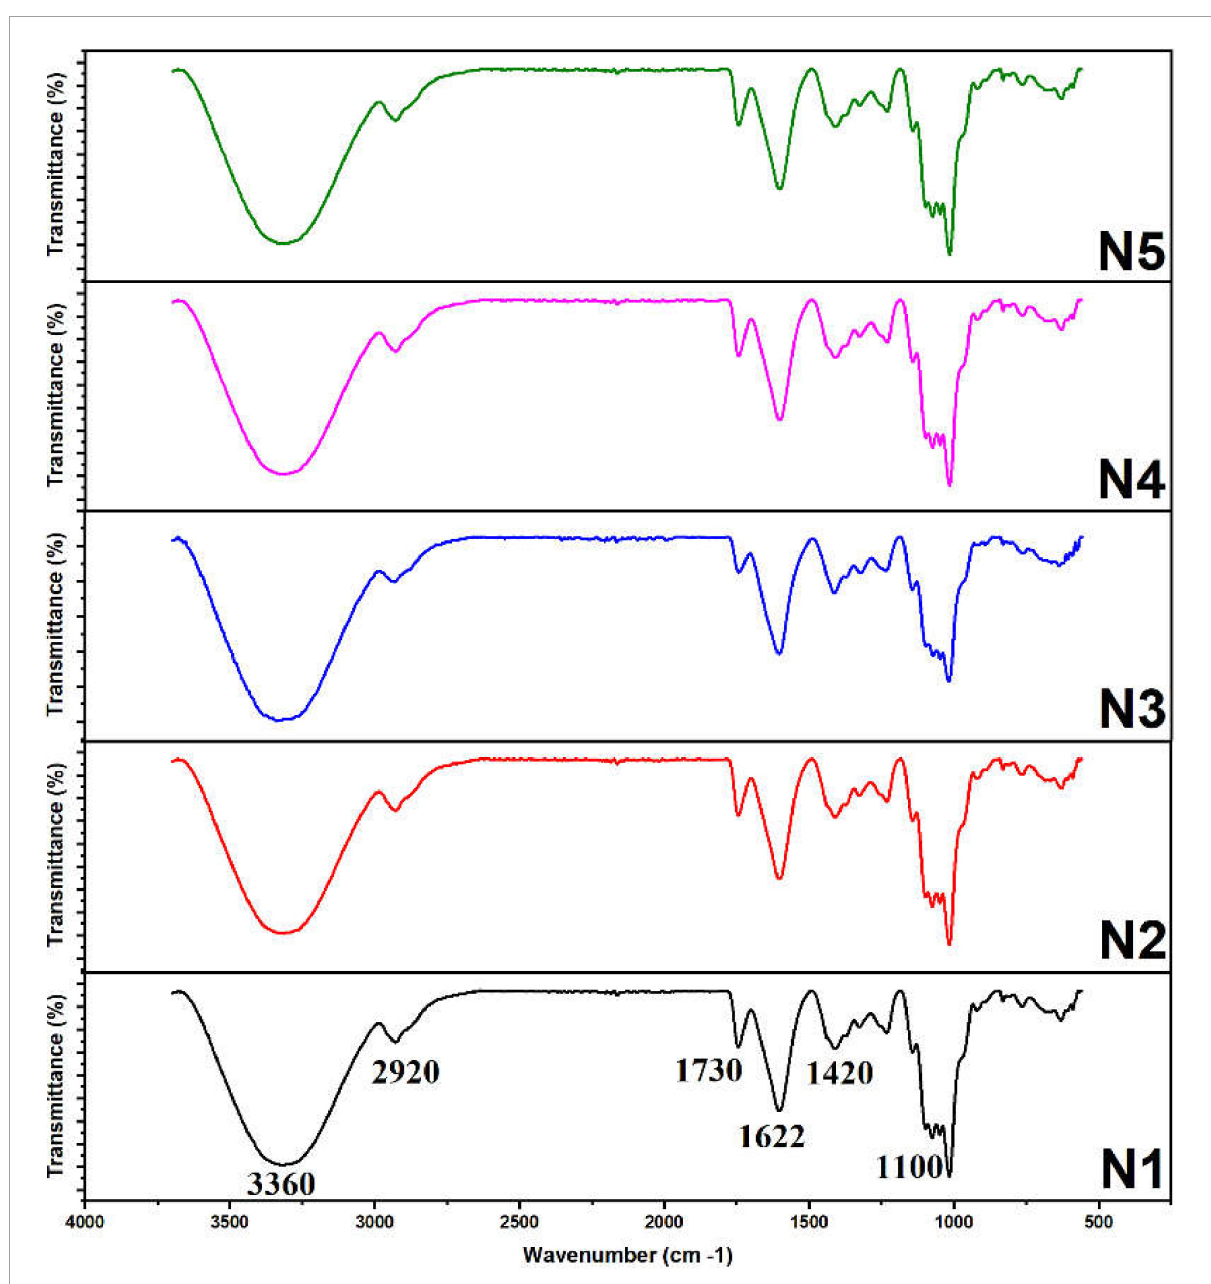
FIGURE2 FT-IR spectra of five Noni polysaccharide samples extracted at different maturity stages.